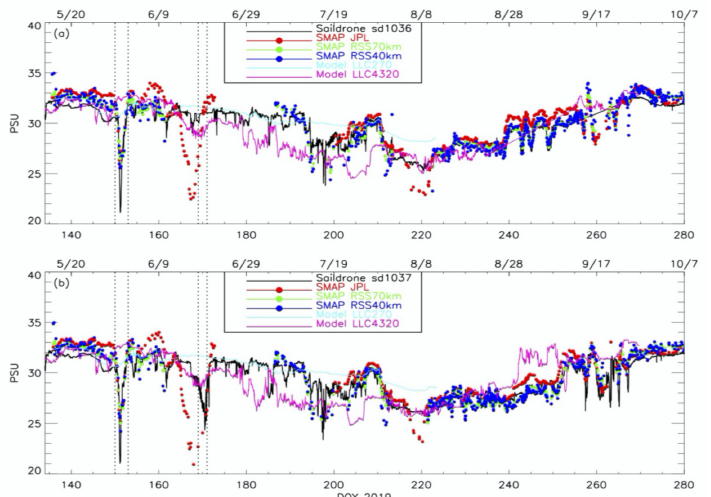
Figure 3. Time series of salinity measured by RBR sensor on ( a ) Saildrone 1036 and ( b ) Saildrone 1037 (in original Saildrone sampling rate) and collocated SMAP SSS and model outputs. Dotted vertical lines indicate the period of two major freshening events (see